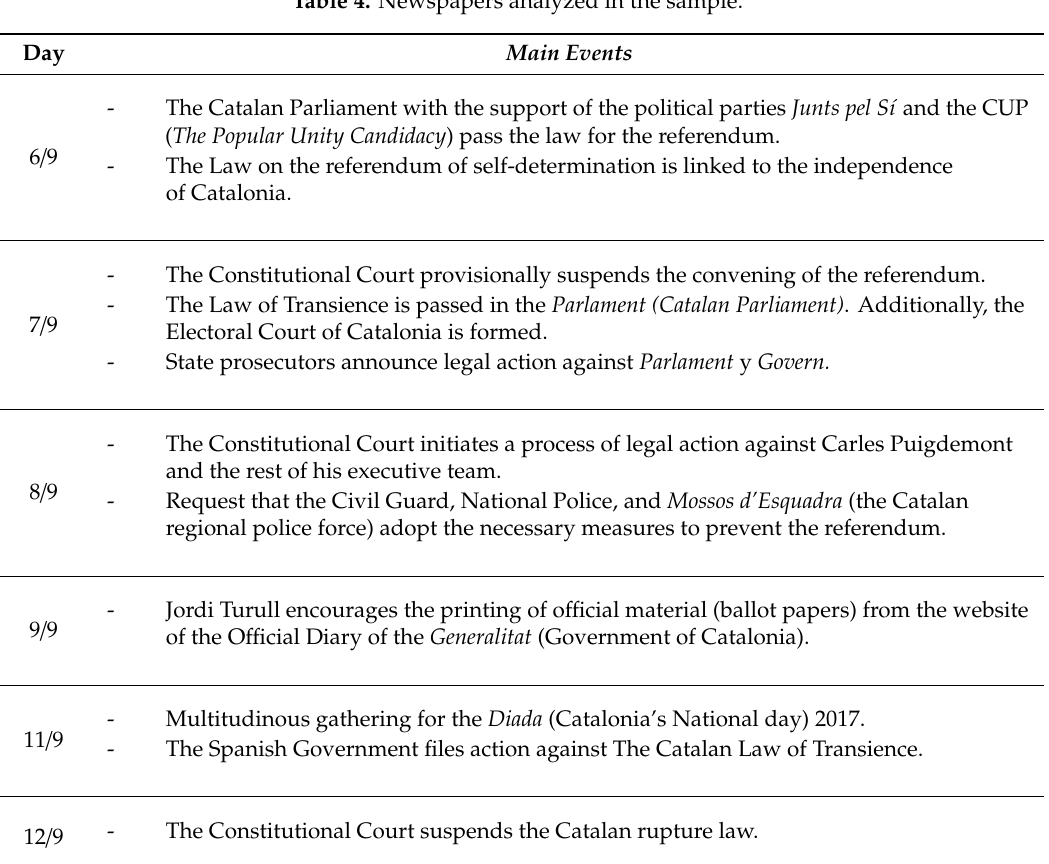
Table 4. Newspapers analyzed in the